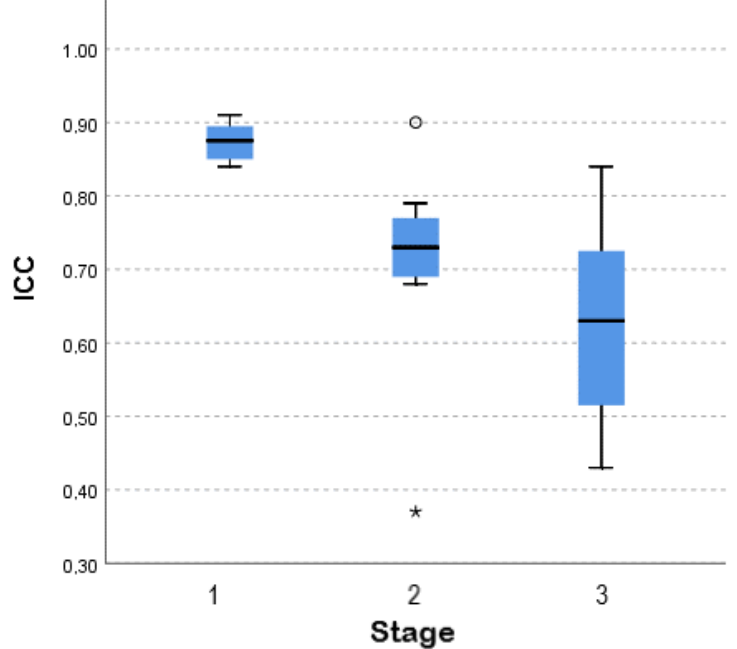
Figure 1. Median test for ICC according to stage. The dimension of the box refers to the interquartile range and vertical lines identify the set of observations which are non-outlier observations. o and * represent, respectively, moderate and severe outliers.